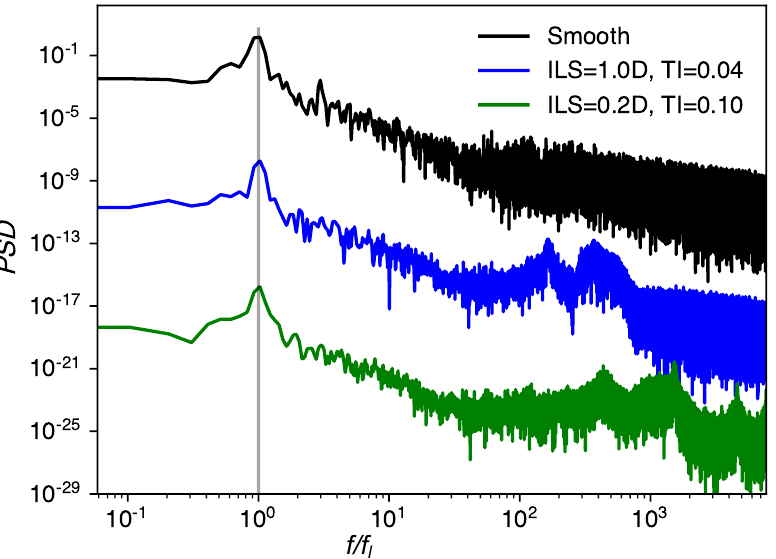
Figure 5. PSD of lift coefficients against frequency ratio f / f l . The spectra of “ ILS = 1.0 D , TI = 0.04” and “ ILS = 0.2 D , TI = 0.10” are shifted down in the vertical axis by 8 and 16 decades,